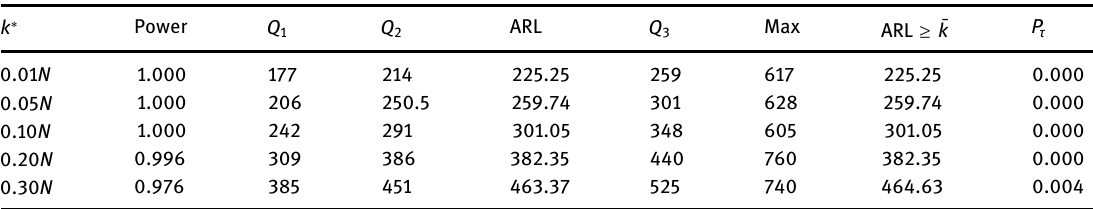
Table 5: Conditional powers, average of run lengths and probability of false alarms for score test with ( ) = g s c s under H A